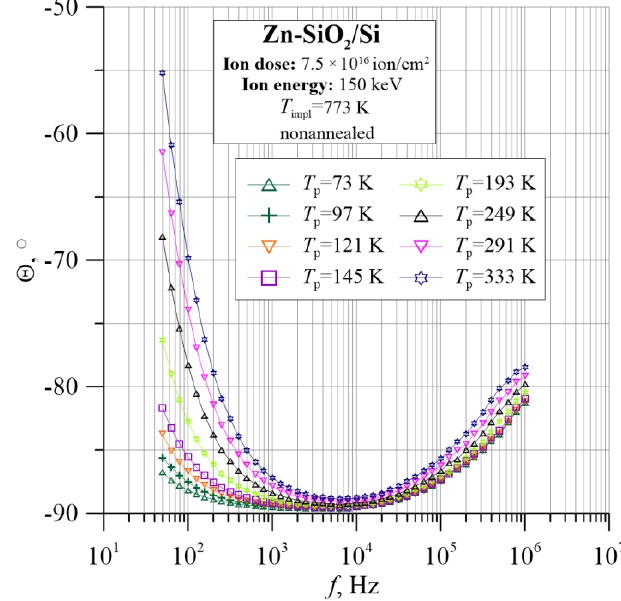
Figure 9. Temperature dependence of the phase shift angle θ for the Zn-SiO 2 /Si nanocomposite immediately after preparation under “hot” implantation conditions (150 keV, 7.5 × 10 16 ion/cm 2 , T impl = 773 K).